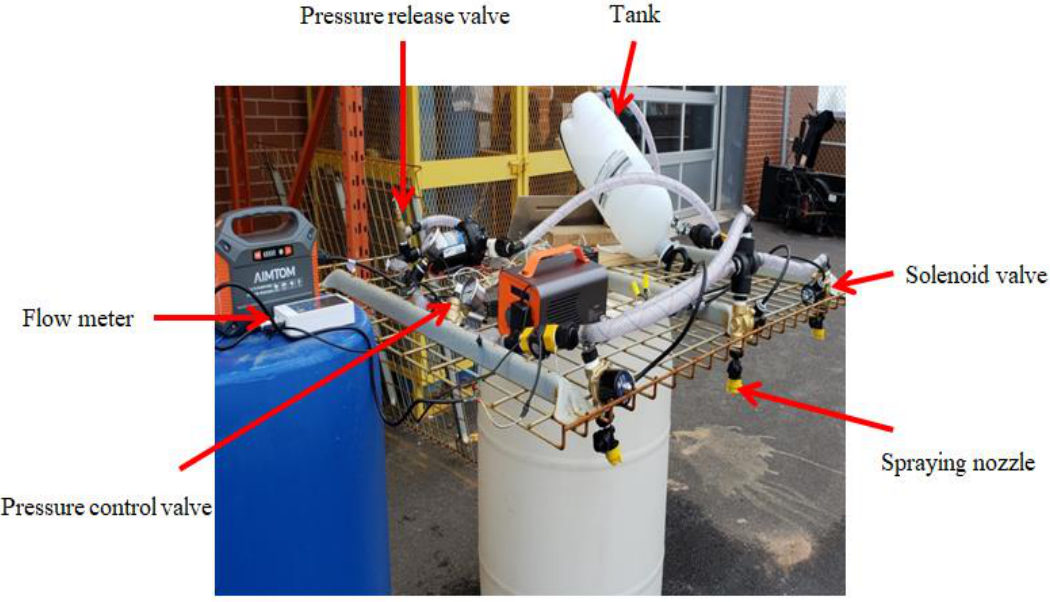
Figure 3. Calibration bed to calibrate the nozzles and different valves of a smart variable rate